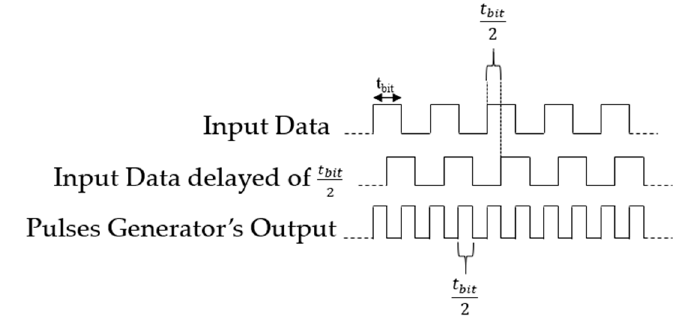
Figure 3. Pulse generator chronogram.